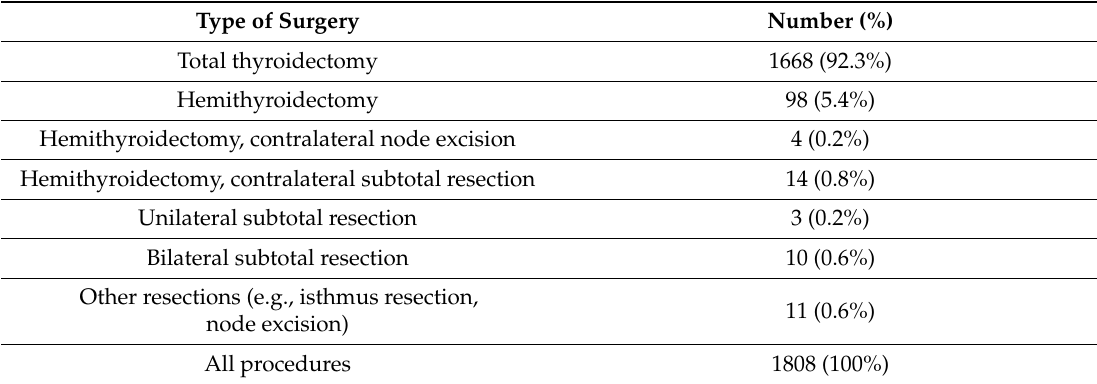
Table 3. Initial thyroid resections performed in 1808 patients with